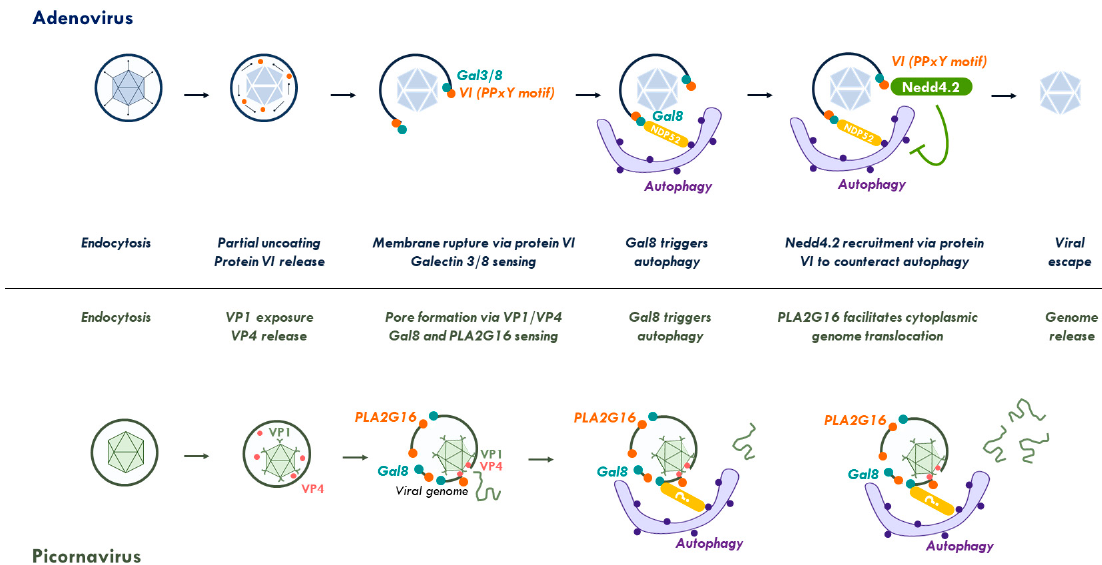
Figure 3. Viral control of the membrane damage response. Top: endocytosed adenoviruses partially uncoat and release the membrane lytic capsid protein VI for endosomal membrane lysis. Membrane damage is sensed by galectins 3 and 8. Galectin 8 recruits autophagic receptors and triggers autophagy. Adenoviruses stall autophagy through a short PPxY peptide motif in protein VI that recruits the ubiquitin ligase Nedd4.2. As a consequence, they avoid degradation and escape into the cytoplasm. Bottom: After endocytosis and acidification of the endosome, picornaviruses undergo conformational changes to expose capsid protein VP1 and release of VP4. Both proteins attach to the endosomal membrane creating membrane-penetrating pores. Membrane damage is then independently sensed by galectin 8 activating autophagy and PLA2G16. PLA2G16 facilitates genome translocation into the cytoplasm preventing autophagic clearance. See Sections 2 and 3 for further details. Abbreviations: Gal, galectin; NDP52, Nuclear dot protein 52; Nedd4.2, neural precursor cell expressed, developmentally down-regulated 4.2; PLA2G16, phospholipase A2 group XVI.